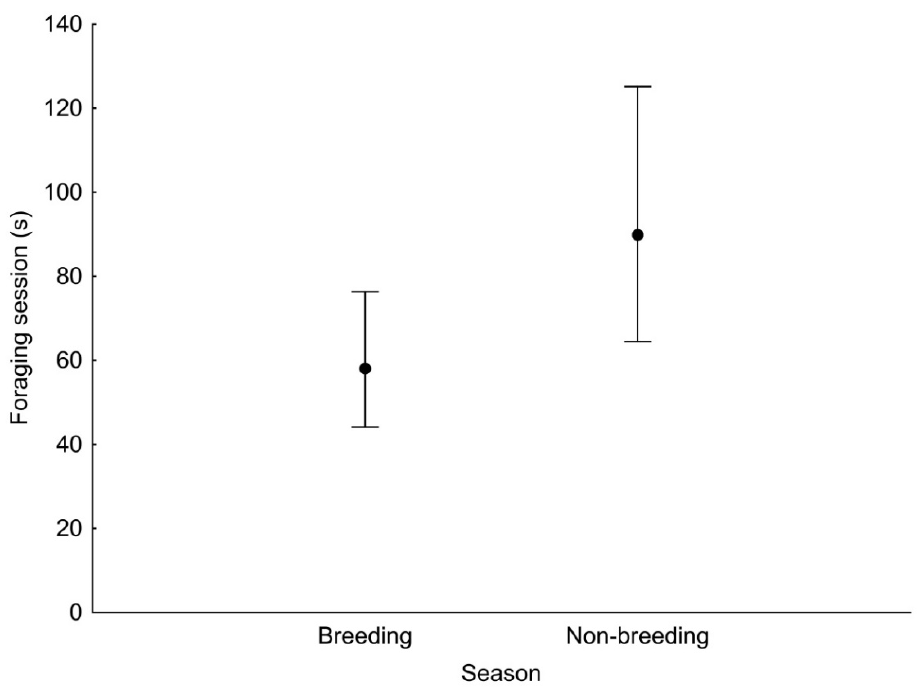
Figure 2. Least squares means with 95% confidence limits (from the statistical model presented in Table 3) of the duration of a foraging session of the Middle Spotted Woodpecker in breeding season and non-breeding season.